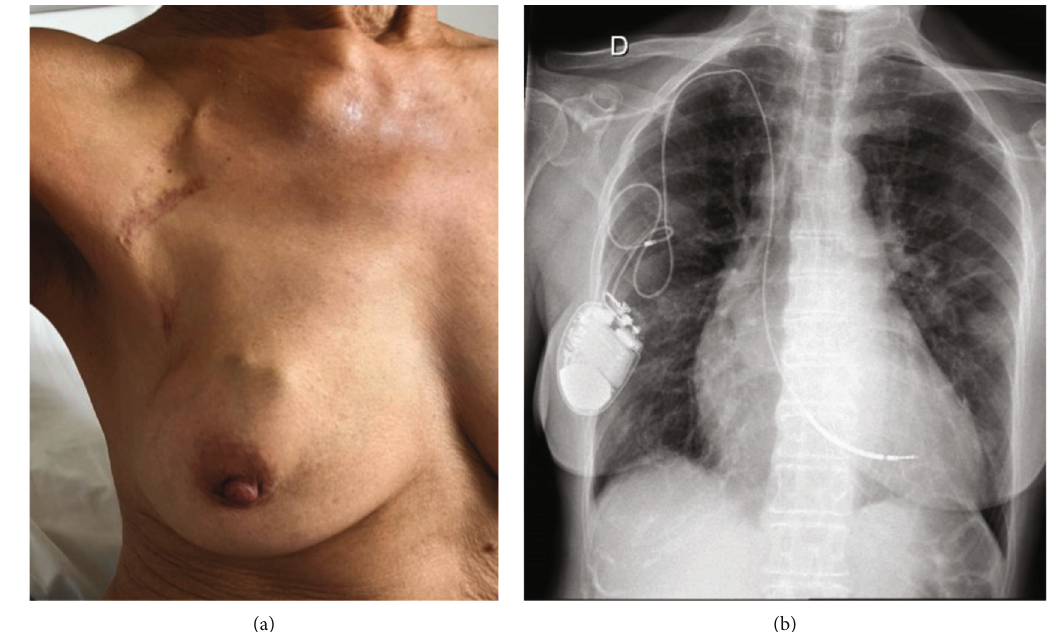
Figure 1: (a) Right thoracic anatomy and (b) anteroposterior chest X-ray.